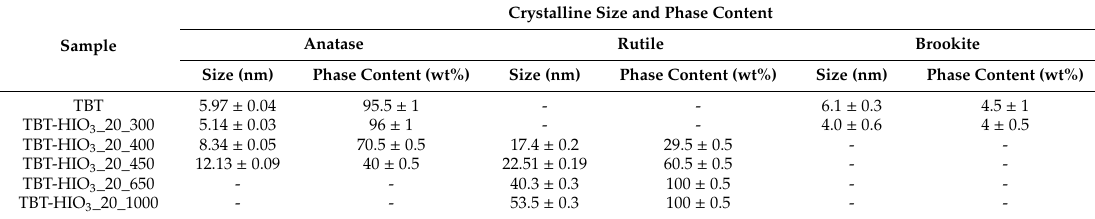
Table 9. Fraction of oxidation states of Ti as well as surface composition of selected defected TBT- HIO 3 _20_T photocatalysts determined by X-ray photoelectron spectroscopy (XPS). Photocatalyst